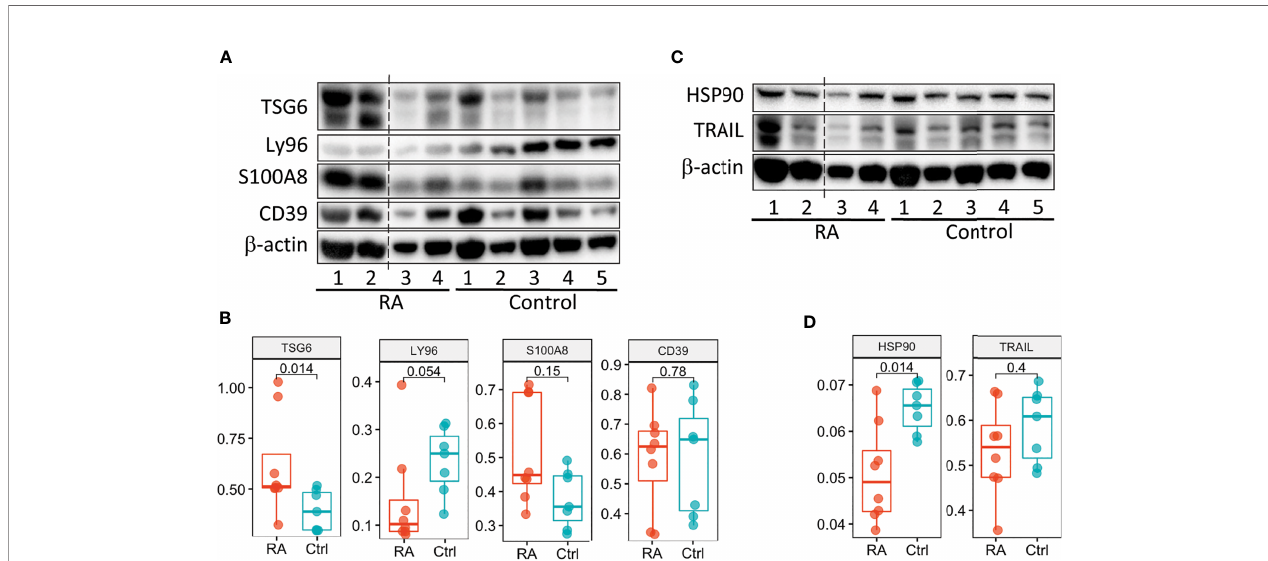
FIGURE 6 | Validation of the RA Score proteins. (A, C) Immunoblot analysis of 6 RA Score proteins in unstimulated PBMC lysates from subjects with RA (n=4) and healthy controls (n=5). Data representative of 2 immunoblots. (B, D) Box plots are quanti fi cation of RA Score protein levels normalized to GAPDH pooled from 2 immunoblot experiments [as shown in (A, C) and Supplemental Figure 8 ]; RA (n=8) and healthy control (n=7) samples. Signi fi cance determined by Mann-Whitney- Wilcoxon test, (B, D) . Dotted line represents lanes removed from non-RA subjects, otherwise immunoblots a and d are montages of the same western